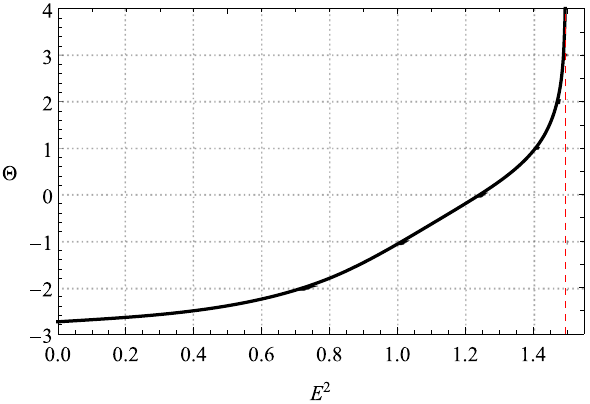
Fig. 5 The behavior of Θ in terms of E 2 , demonstrated for L = 2, Q = 1 and λ = 10. As it is expected, the scattering angle reaches its limit as E tends to E U which in this case is around